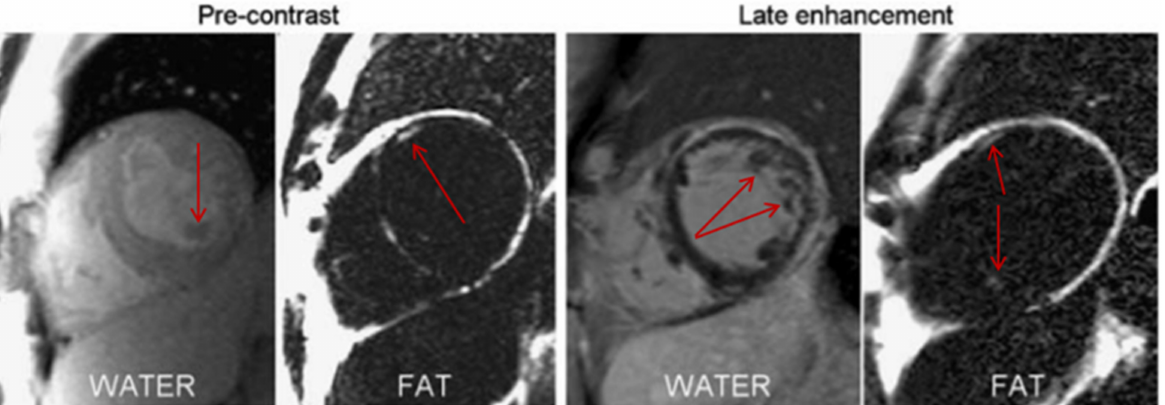
Figure 6. Fibrofatty infiltrates highlighted in fat-water separated MRI pre-contrast ( left ) and late enhancement ( right ) in a patient with non-ischemic cardiomyopathy. Reproduced from Kellman et al. [46] under the Creative Commons Attribution Noncommercial